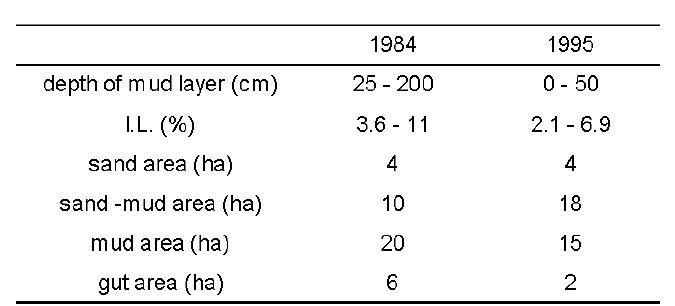
Comparison of Sediment